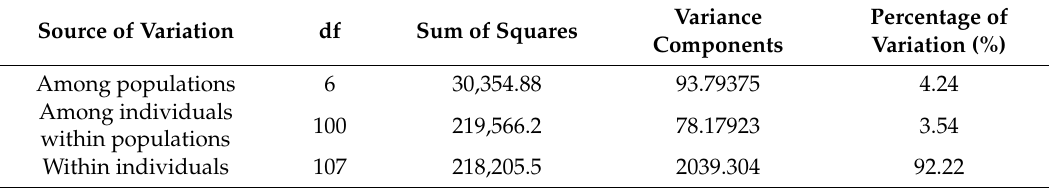
Table 5. Analysis of molecular variance (AMOVA) of genetic diversity of Chinese elm